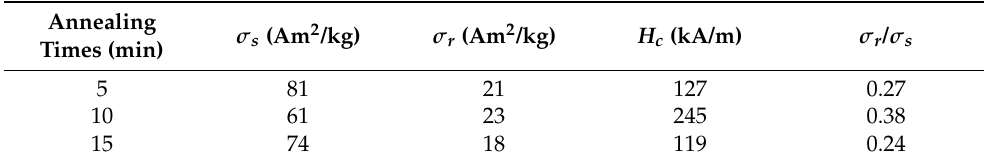
Figure 7. Hysteresis loop curves of the microwave annealed (Nd 0.525 Pr 0.175 Ce 0.3 ) 9 Fe 64.5 Co 3 Cu 0.5 Ti 1 B 22 ribbons for a different time. Table 4. The magnetic properties of the annealed (Nd 0.525 Pr 0.175 Ce 0.3 ) 9 Fe 64.5 Co 3 Cu 0.5 Ti 1 B 22 ribbons for a different time.